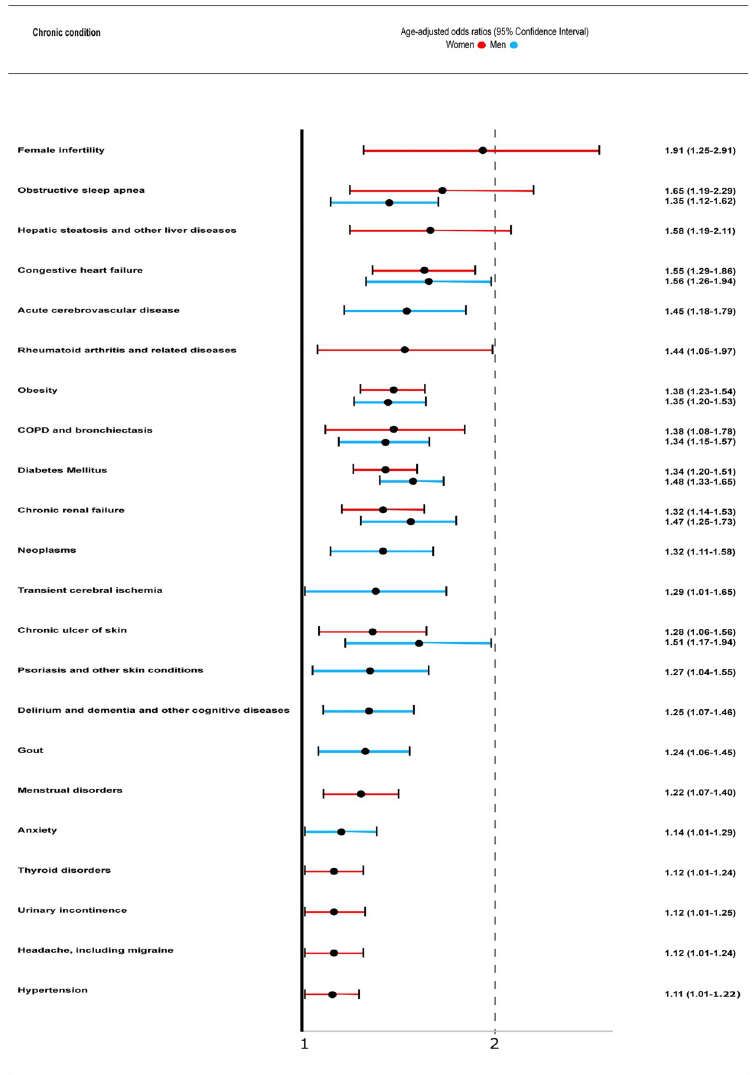
Fig 1. Baseline chronic comorbidities associated with moderate-to-severe infection, defined as the combined outcome of hospital admission and 30-day all-cause mortality, in women (red) and men (blue) with COVID-19 infection. COPD, chronic obstructive pulmonary disease.